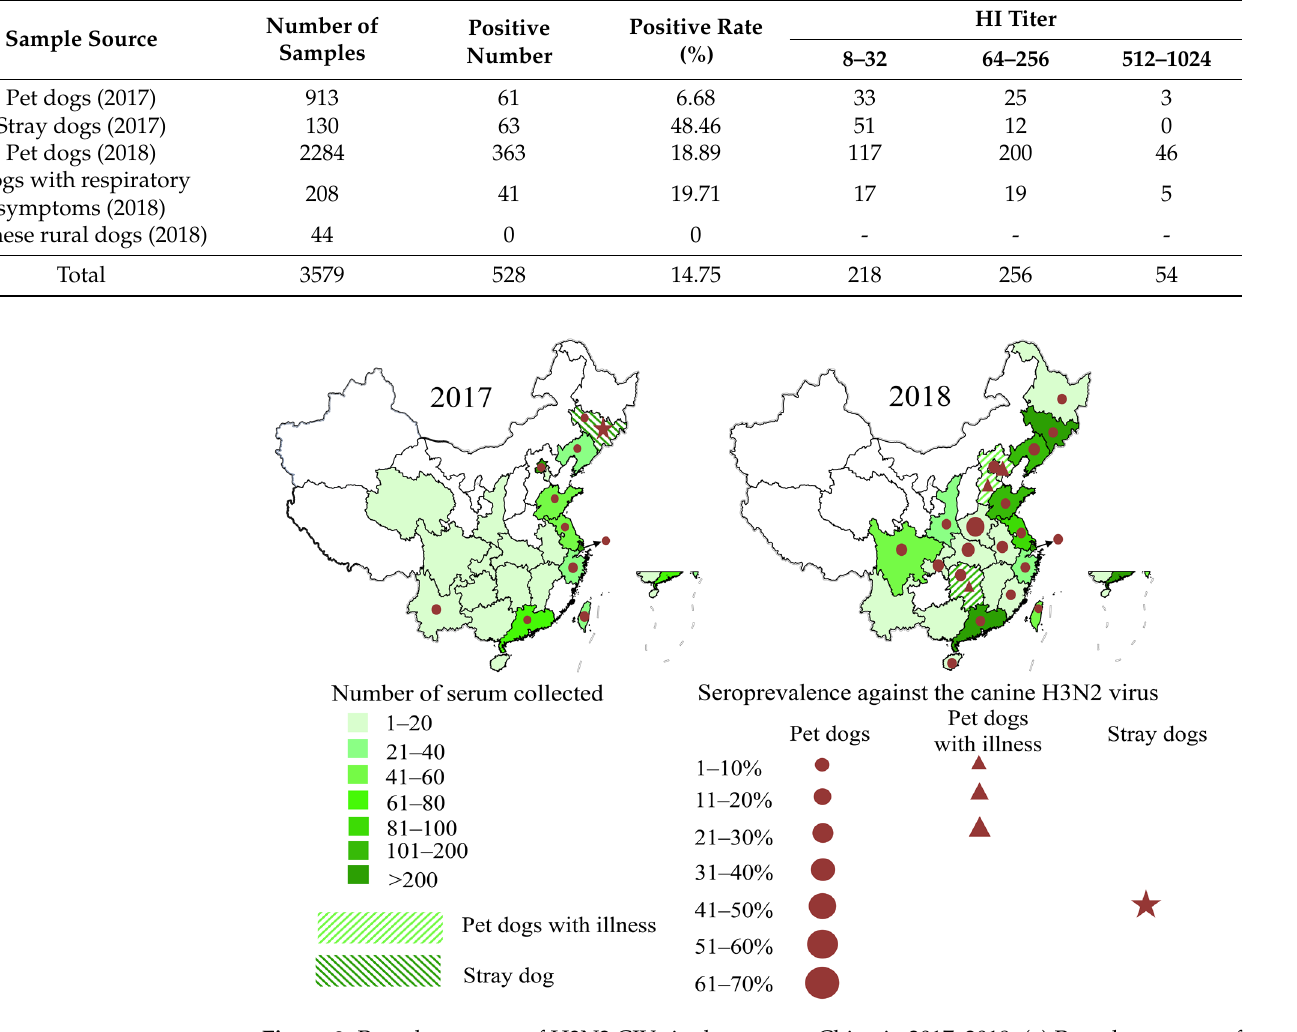
Table 1. Seroprevalence of CIV in pet dogs in China.